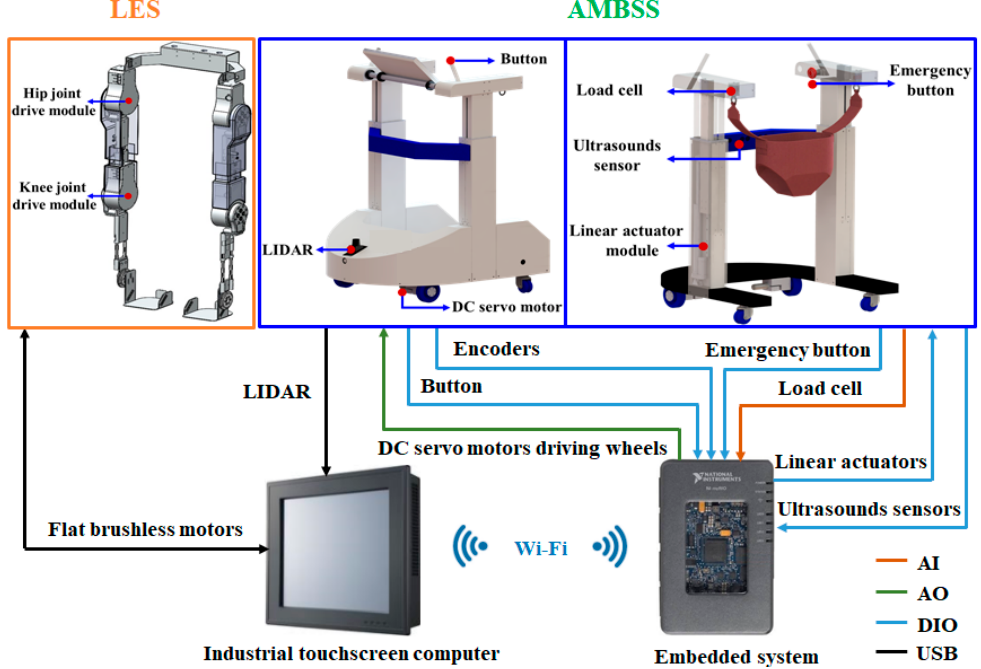
Figure 4. MRR’s control system architecture diagram.